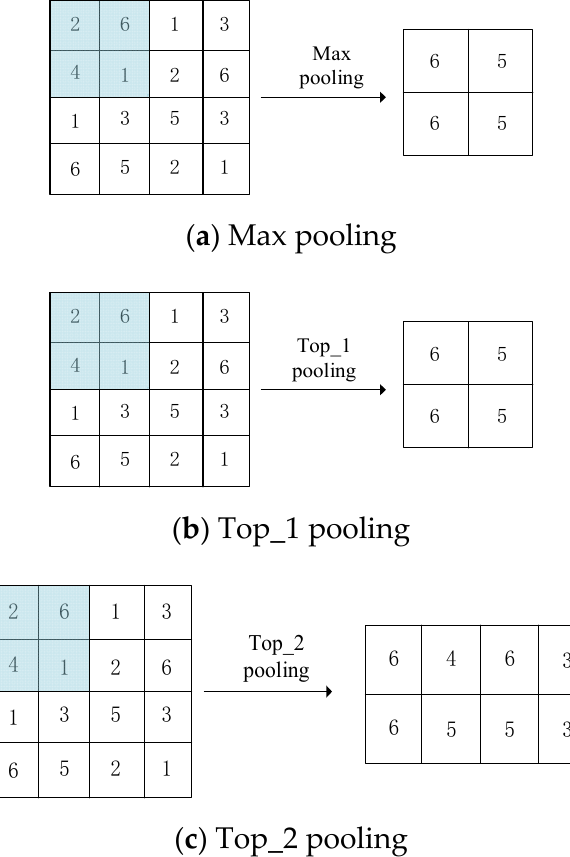
Figure 5. Calculation process of max pooling and top-k pooling.